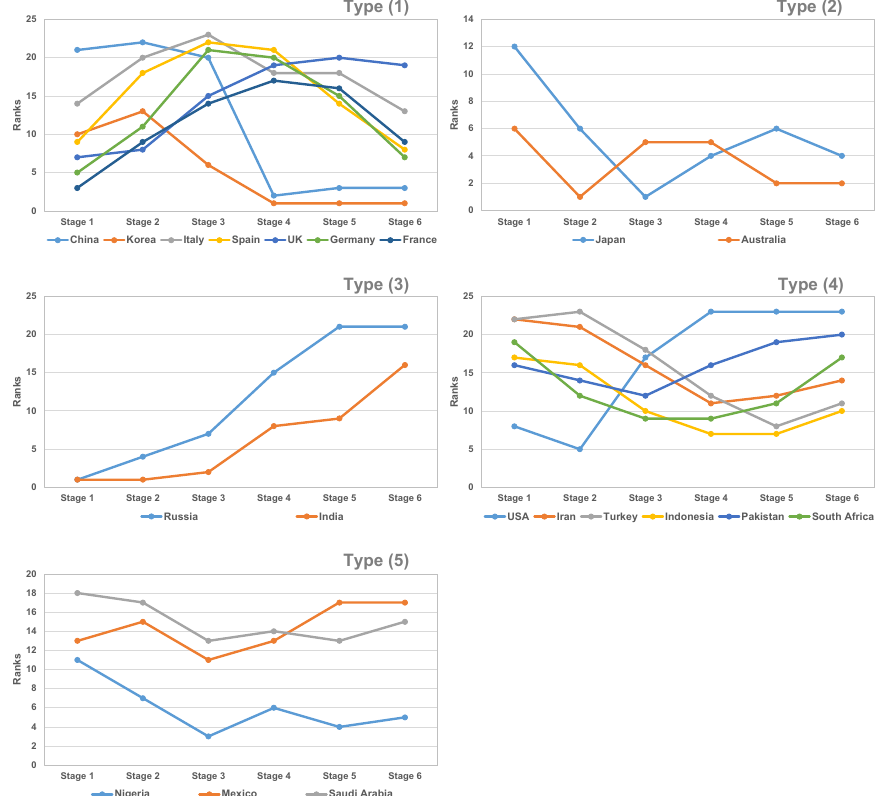
Figure 2. The trends in efficiency rank for countries of Types ( 1 )–( 5 ).